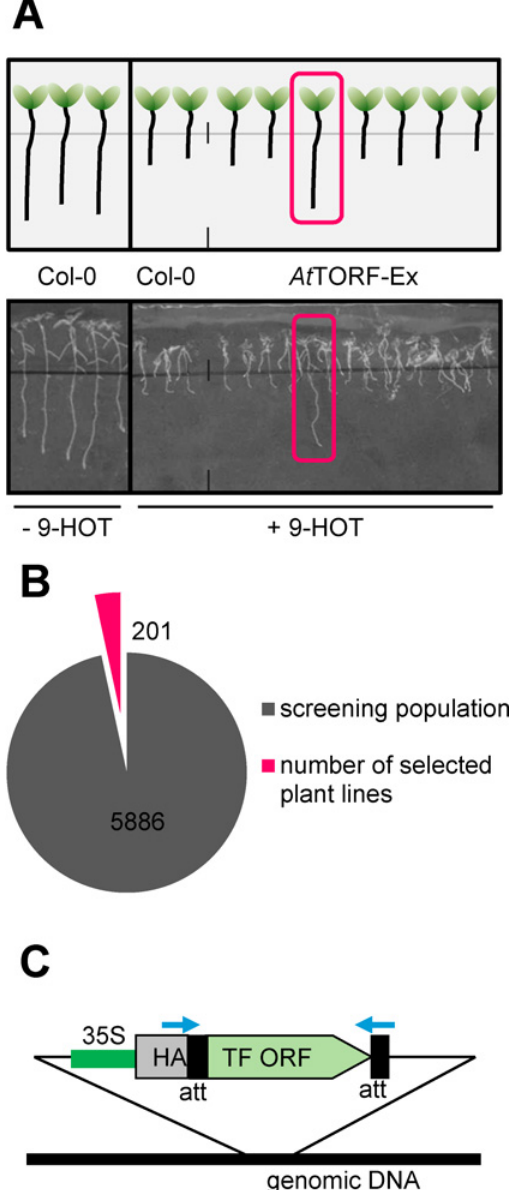
Fig 1. Schematic overview of the At TORF-Ex screening. (A) Col-0 and At TORF-Ex [21] seedlings are cultivated on MS-Medium without or with 25 μ M 9-HOT for 5 d. Individuals showing unimpaired root growth on the 9-LOX-oxylipin (marked in red) were isolated for further analysis. (B) Overview of screening results: Out of 6000 At TORF-Ex lines, 201 individuals were selected. (C) At TORF-Ex transgenes are flanked by GATEWAY 1 att-sites (black) which enable PCR-amplification and sequencing of TF genes using the indicated primers (blue arrows). 80 independent TFs were identified and listed in Table 1. Due to N-terminal fusion of HA-tag, TF genes encoded proteins can be detected via